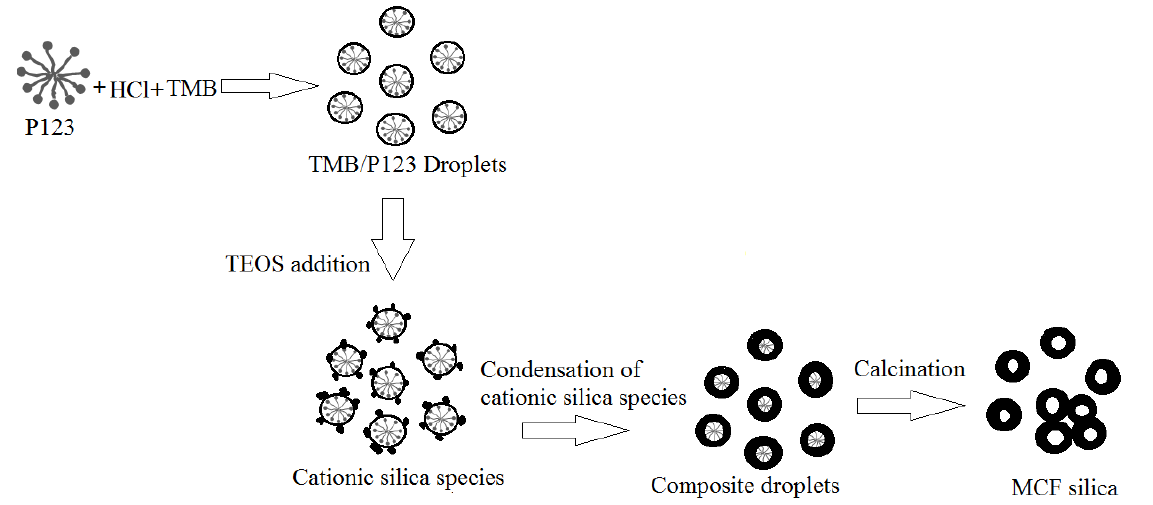
Figure 3: Formation of MCF silica